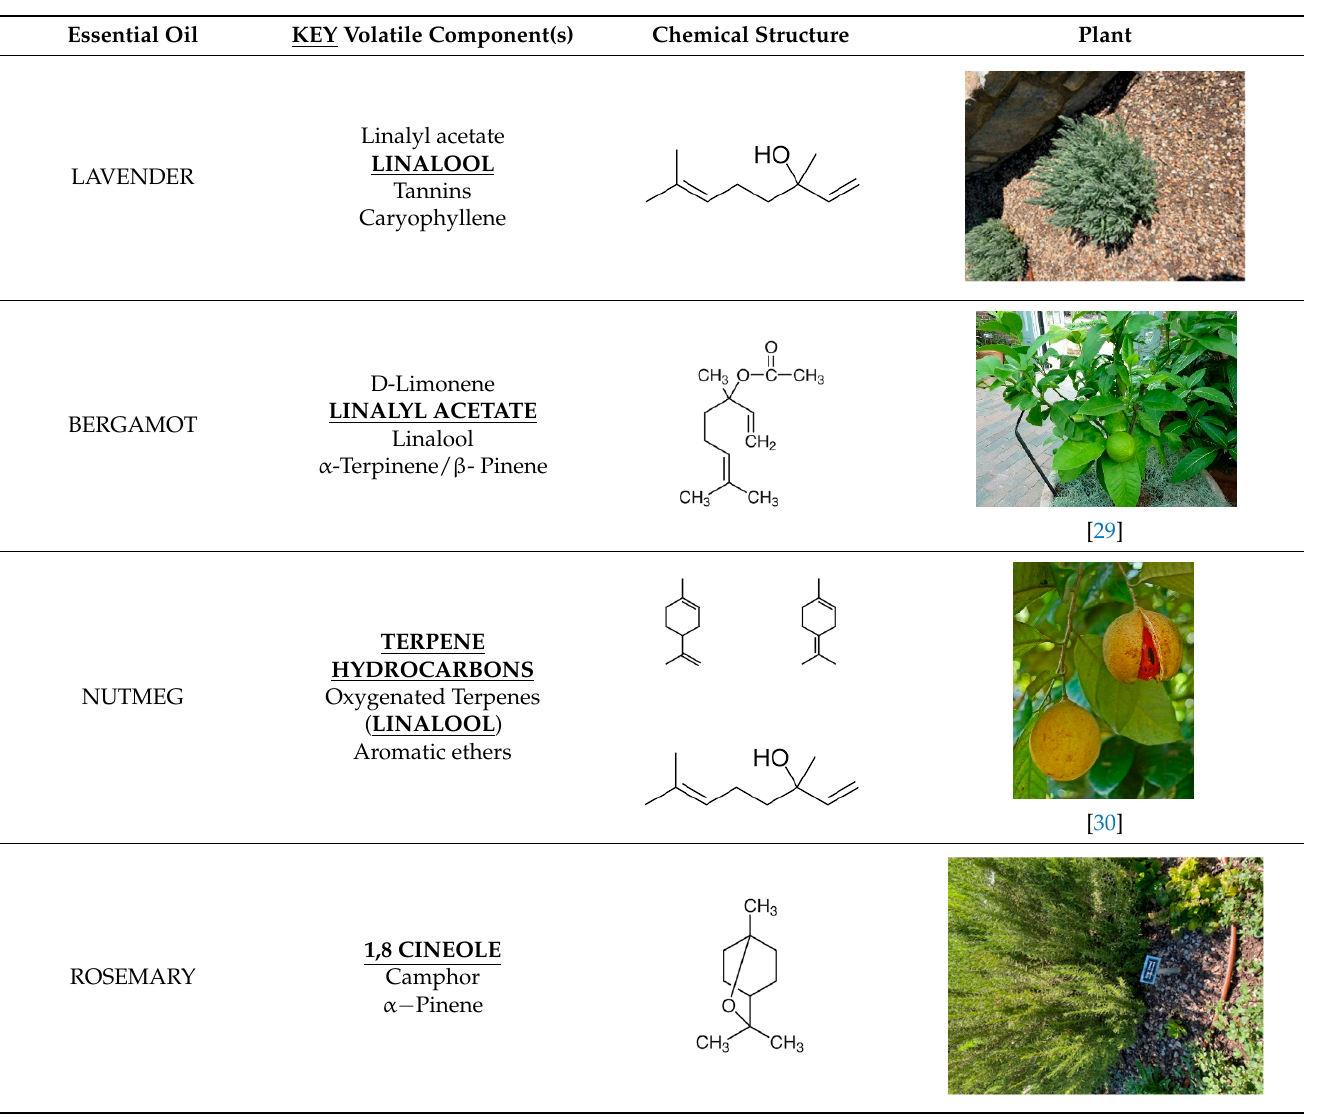
Table 2. Essential Oil, Key volatile components, chemical structure and Plant.